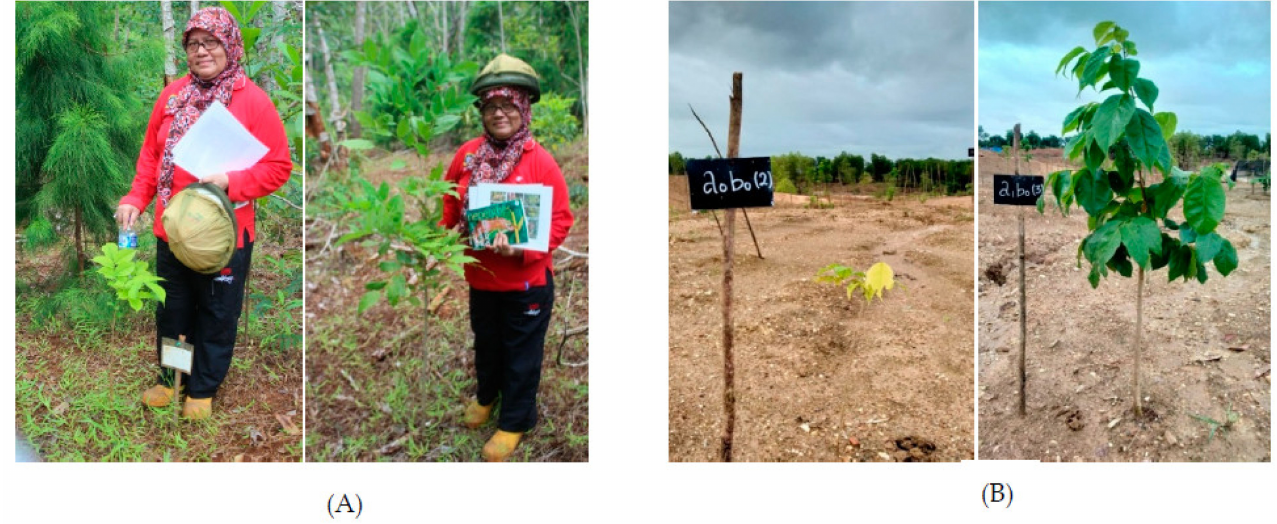
Figure 5. Visualization of growth performance of P. mooniana with and without mycorrhizal in a post-nickel field at 12 months ( A ) and a post-gold mine at four months after planting ( B ) (Photo: F.D. Tuheteru and Husna,